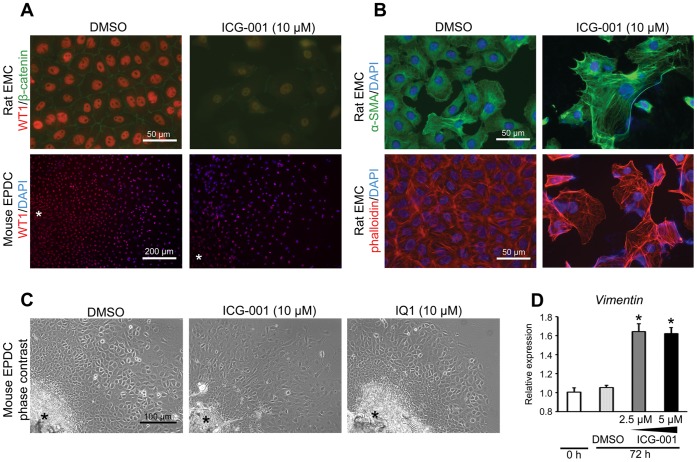
Immunocytochemical analysis of epicardial cells treated with ICG-001.(A) ICG-001 decreased nuclear WT1 protein expression, an epicardial cell marker, by immunocytochemistry, both in rat EMCs and mouse epicardium-derived cells (mouse EPDCs). Fluorescence colors: red; WT1, green; β-catenin, blue; DAPI/nuclear stain. *; Original epicardial explant. (B) ICG-001 increased α-SMA smooth muscle actin filaments in rat EMCs. Fluorescence colors: green; α-SMA, red; phalloidin/F-actin filament, blue; DAPI/nuclear stain. (C) ICG-001 decreased the cobblestone patterning of mouse EPDCs by phase contrast microscopy. *; Original epicardial explant. (D) ICG-001 significantly increased the expression of Vimentin by qPCR in rat EMCs. *P<0.05. Data are presented as mean ± s.e.m.